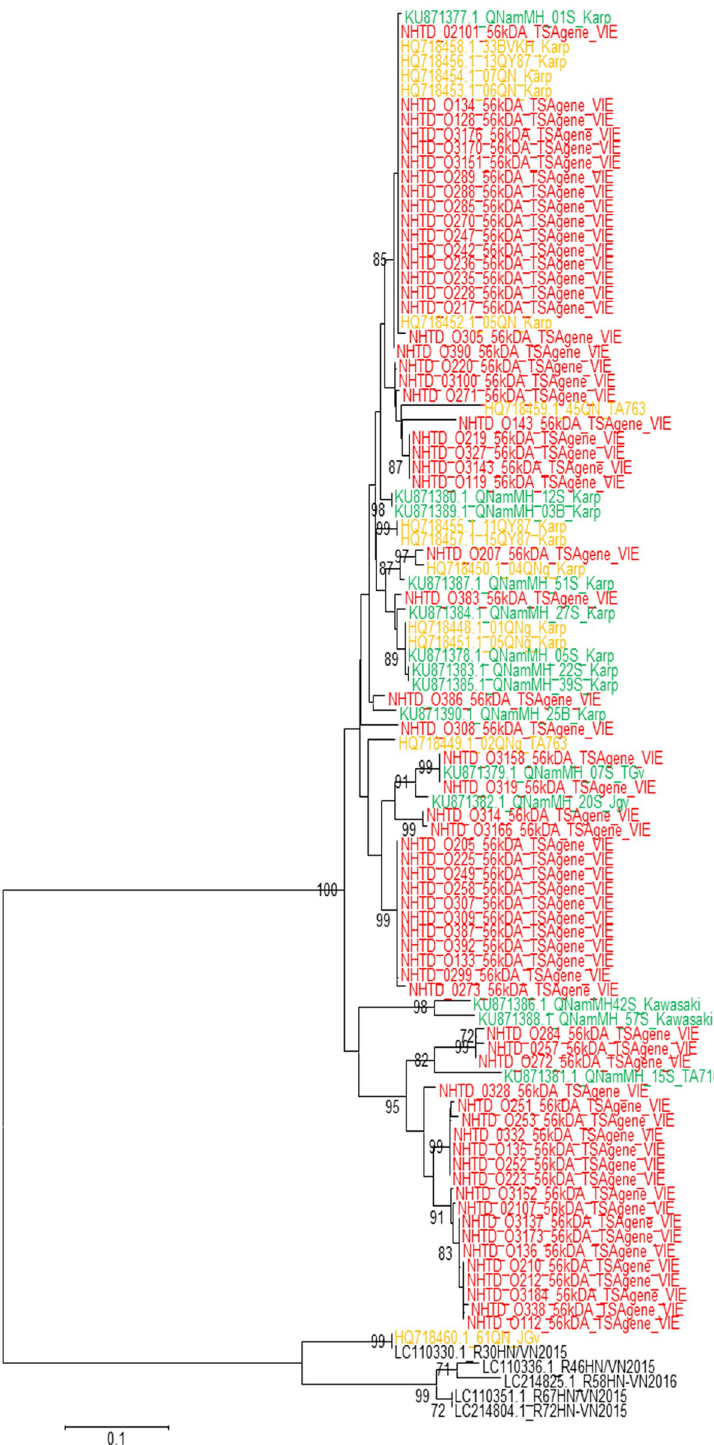
Fig 3. Phylogenetic tree of 56kDa TSA gene Orientia tsutsugamushi sequences detected in Vietnam. This subset consists of sequences from this study (red font), 14 sequences from the reference [5] (green font), 13 sequences from the reference [15] (orange font) from central Vietnam, and 5 sequences from northern Vietnam, the reference [6] (black font).